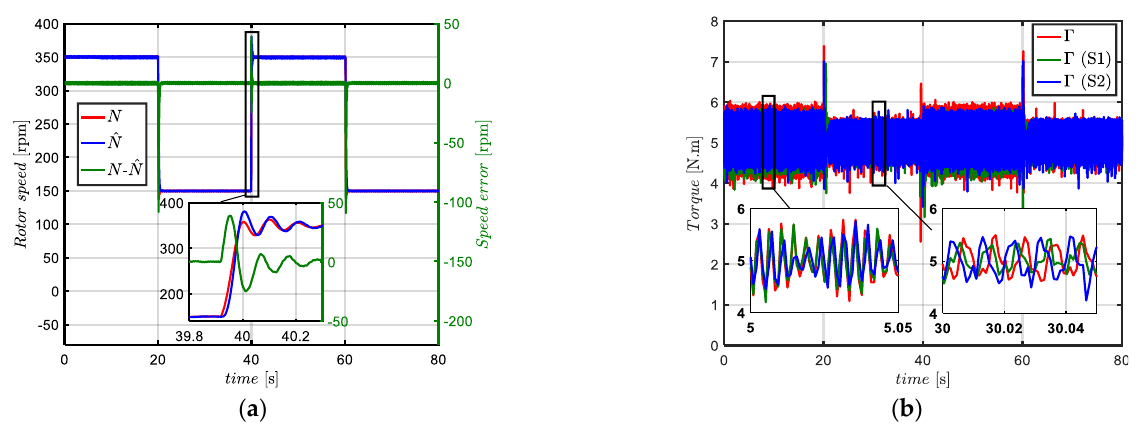
Figure 27. Experimental waveforms for variable rotor speed: ( a ) measured and estimated rotor speed, ( b ) measured torque when the seven-phase PMSM is controlled by the encoder, sensorless control ( S1 ), and sensorless control ( S2 ).